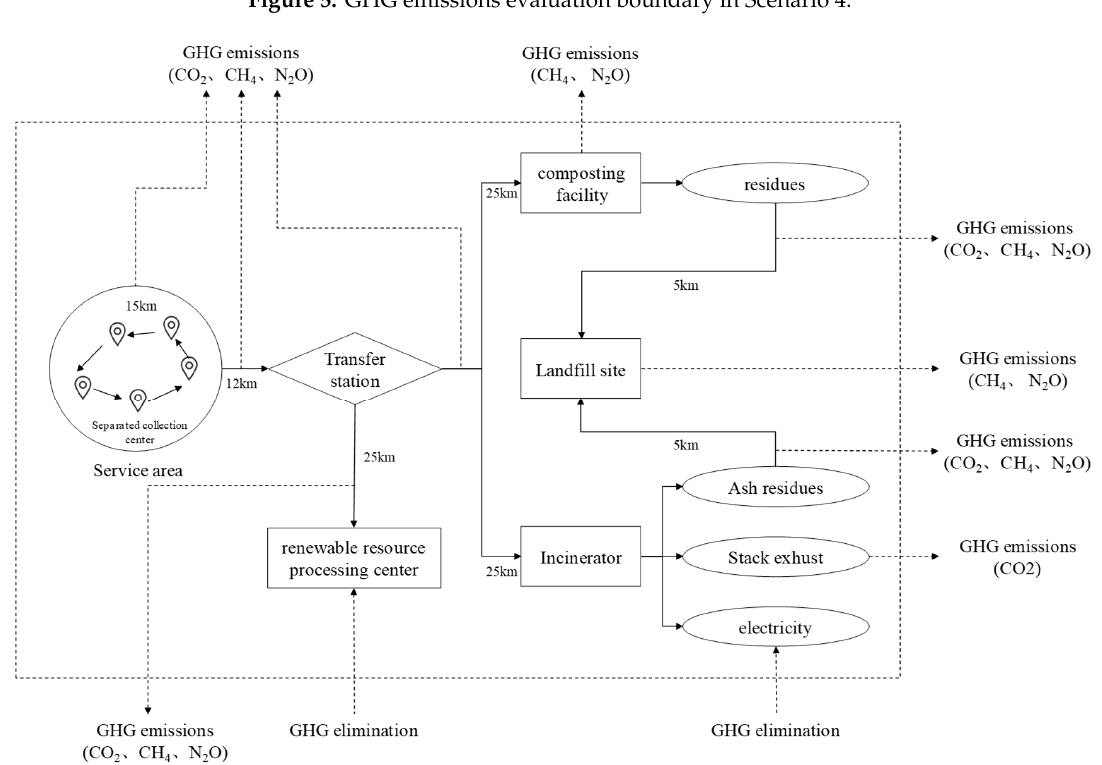
Figure 6. GHG emissions evaluation boundary in Scenario 5.